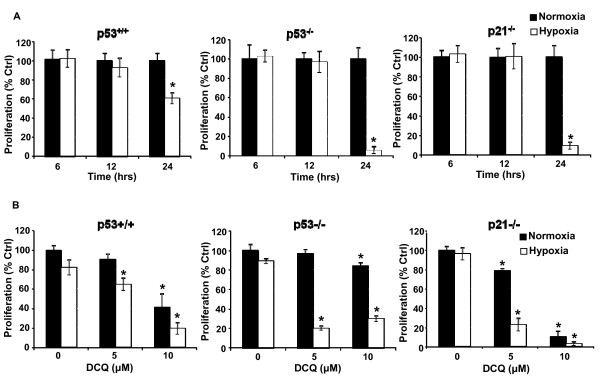
DCQ reduces the viability of HCT116 cells more so under hypoxia than normoxia. (A) The effect of hypoxia on HCT116 (p53+/+, p53-/-, p21-/-) cell viability after 6, 12, or 24 hrs of exposure to 1% O2. Cells were plated in 96 well plates at 1.2 × 105 cells/ml and treated at 50% confluency. Viability was determined using Cell Titer 96 non-radioactive proliferation assay. (B) Dose-dependent decrease in the viability of cells exposed to DCQ for 6 hrs and cultured under normoxia or hypoxia. Values are averages ± SD of two independent experiments each done in triplicates; (*) indicates p < 0.05 (one way ANOVA). ■ Normoxia □ Hypoxia. The experiment was repeated three times each in quadruplicates.